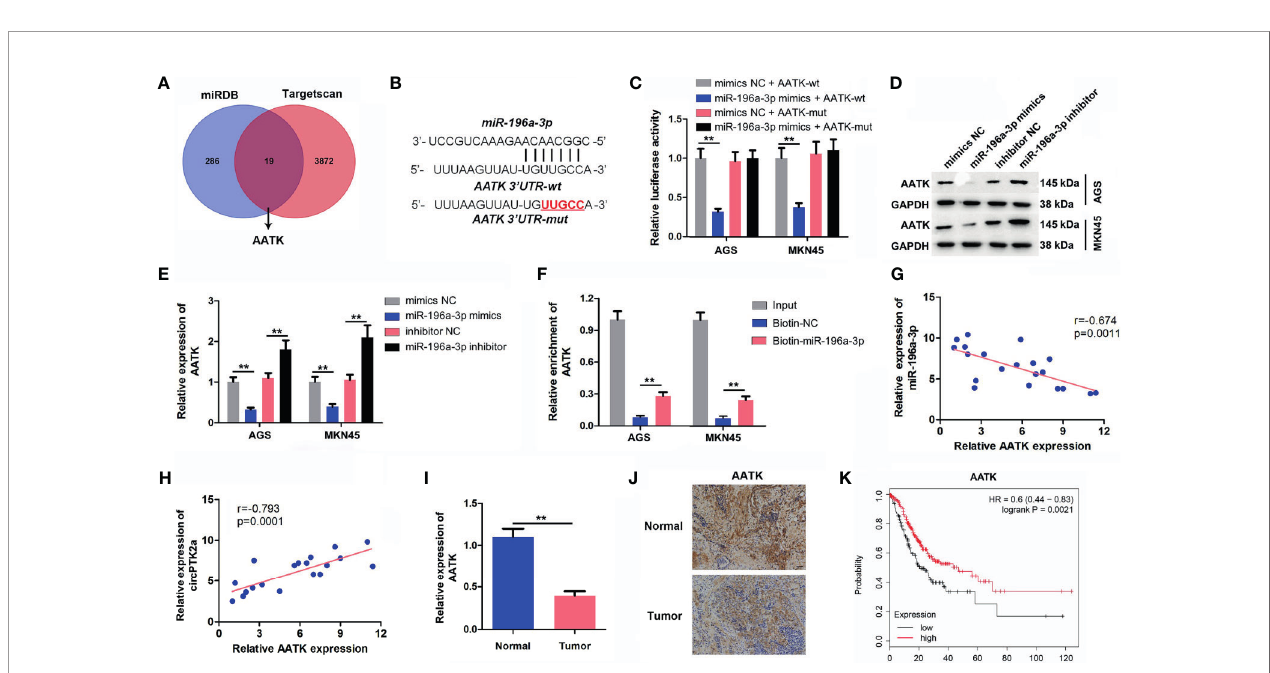
FIGURE 6 | AATK is a direct binding target of miR − 196a-3p. (A) Screen of the candidate genes that target miR-196a-3p predicted by miRDB and TargetScan. (B) Schematic diagram of binding sites between AATK and miR-196a-3p. (C) Luciferase activity analysis in AGS and MKN45 cells co-transfected with the AATK-wt/ mut vectors together with miR-196a-3p mimics or mimics control. (D, E) Western blot analysis of AATK expression in AGS and MKN45 cells transfected with miR- 196a-3p mimics or miR-196a-3p inhibitor. (F) RNA pull-down assay was performed in AGS and MKN45 cells to verify the binding between AATK and miR-196a-3p. (G, H) The Pearson ’ s correlation coef fi cients showed the correlation between AATK and miR-196a-3p or between AATK and circPTK2 in gastric cancer tissues. (I) RT-qPCR and (J) IHC analysis of AATK level in tumor tissues and in normal tissue. (K) Survival analysis of the correlation between AATK levels and survival rates in gastric cancer patients. ** p < 0.01. The signi fi cance between two or more groups was analyzed by Student ’ s t -test or one-way ANOVA,